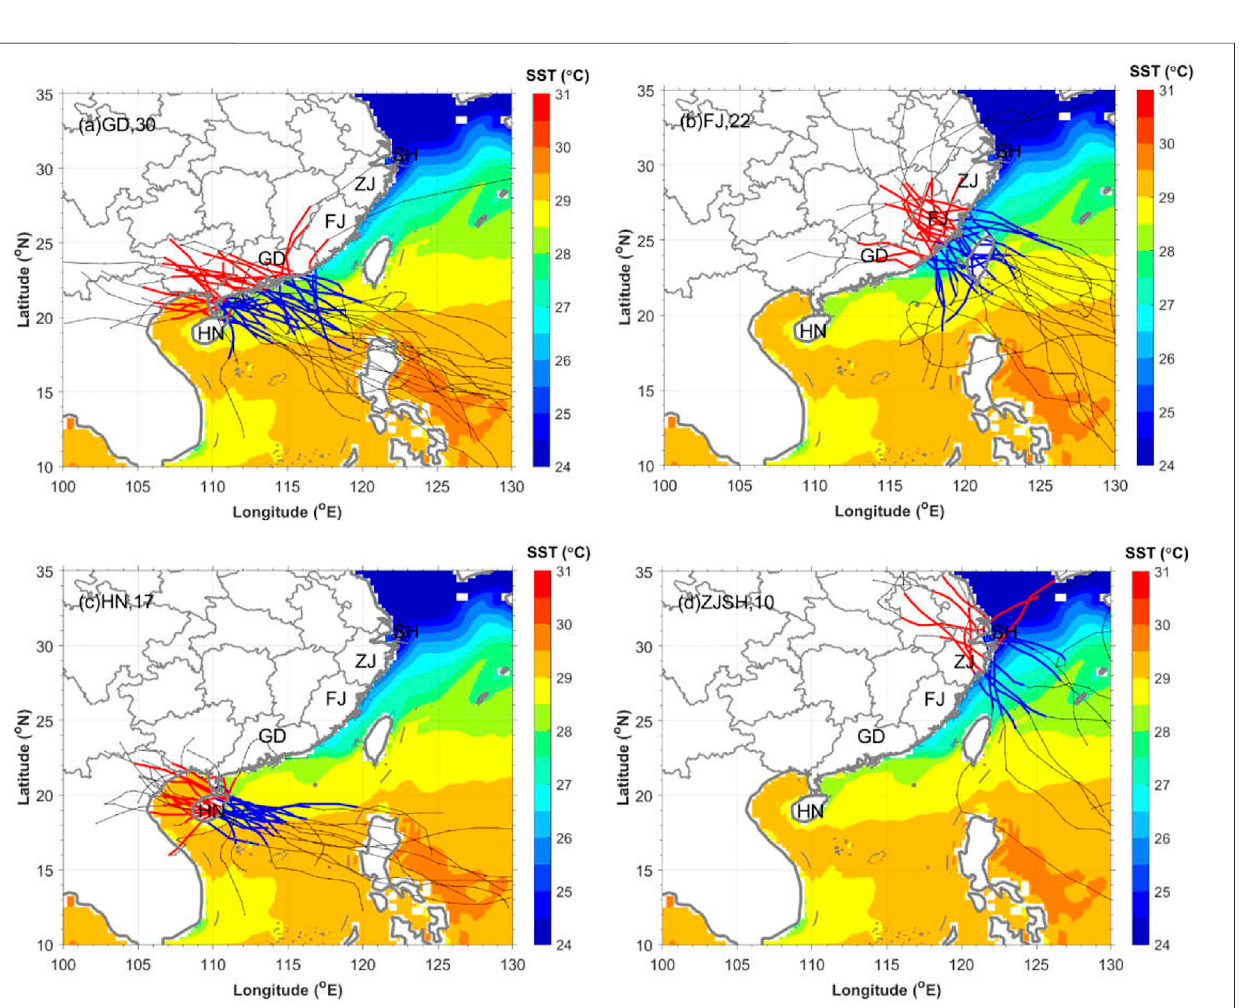
Frontiers in Earth Science |